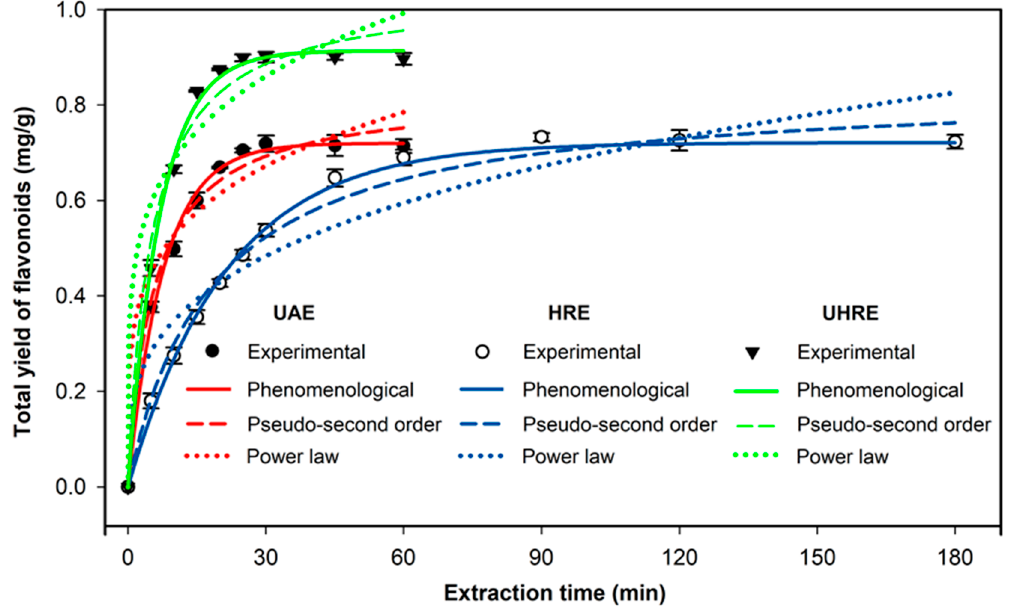
Figure 6. The dynamic curves of total yield of flavonoids obtained using three different methods on extraction time. Total yield of flavonoids (mg/g) = QU yield + KA yield + GI yield + SC yield.